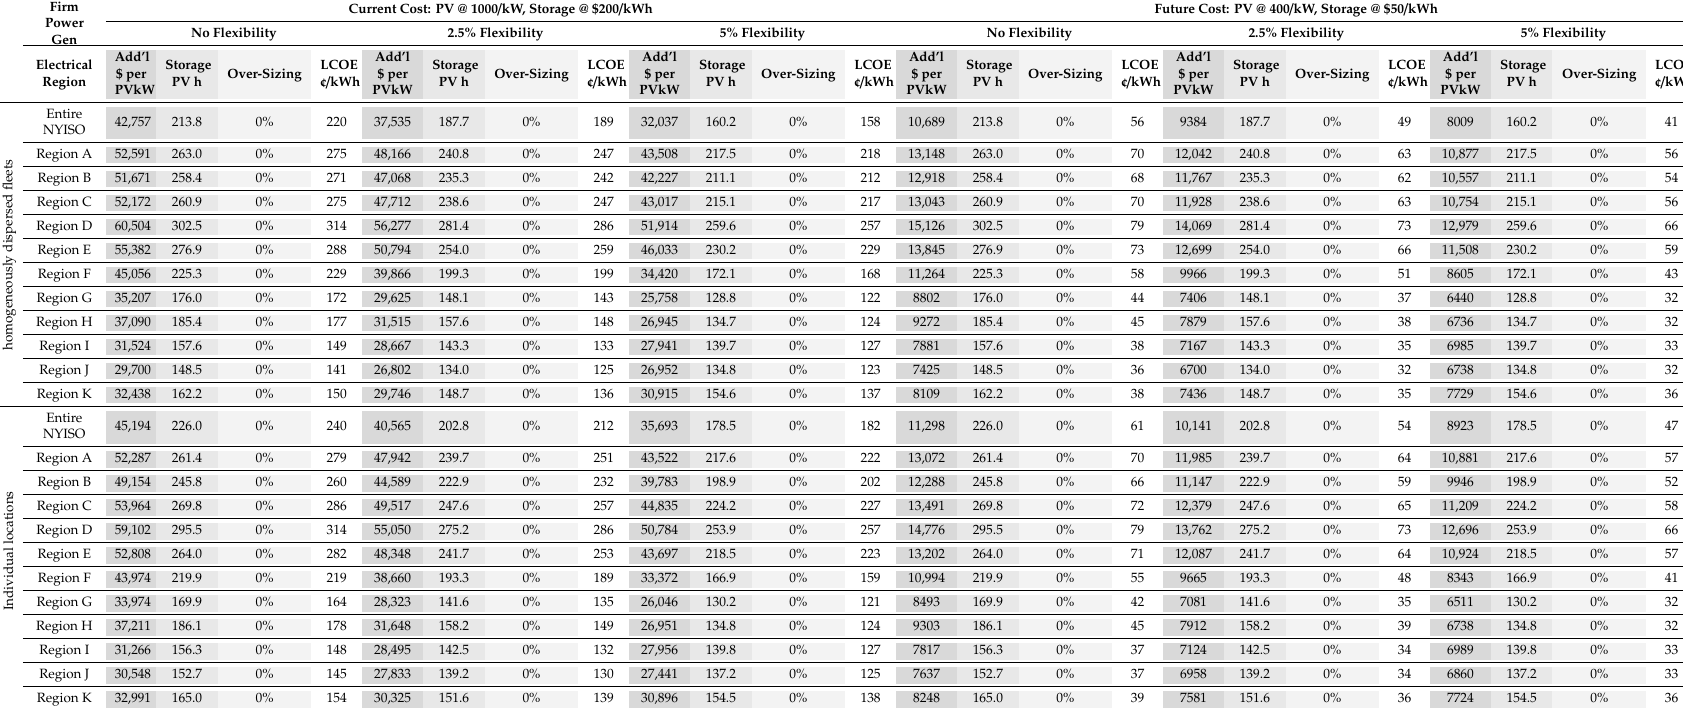
Table 5. Firm power generation w / o implicit